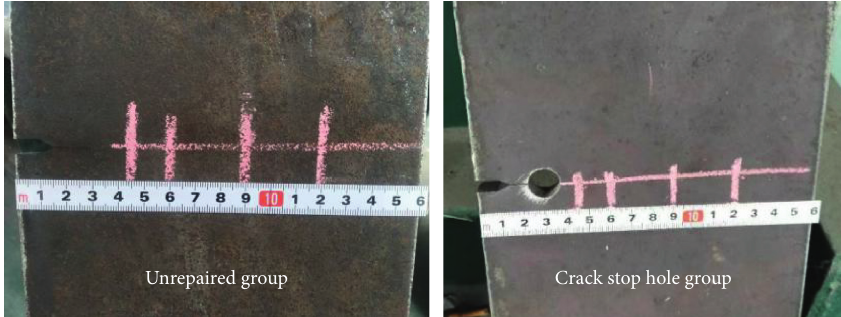
Figure 13: Unrepaired group and crack stop-hole group.